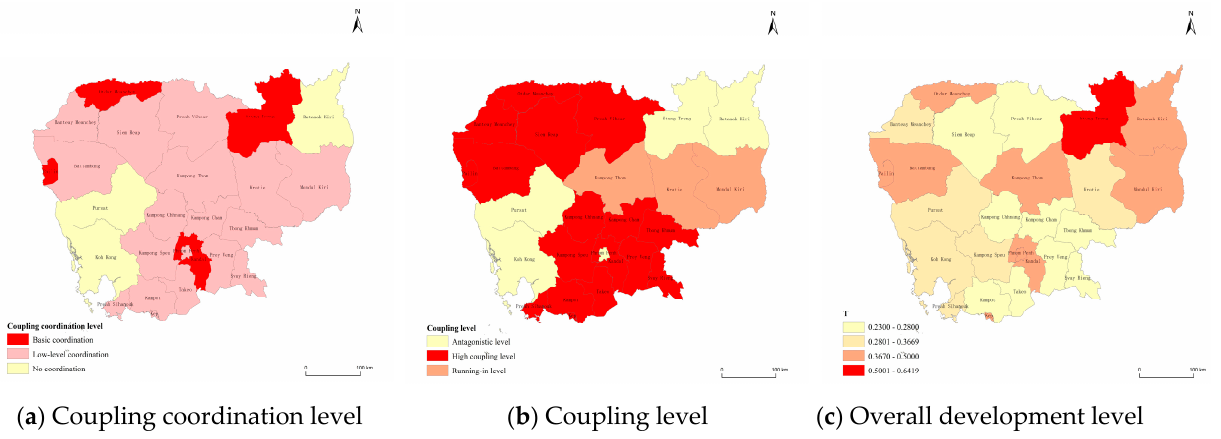
Figure 5. Coupling characteristics of agricultural production, road construction, and agro-ecological environment in Cambodia.